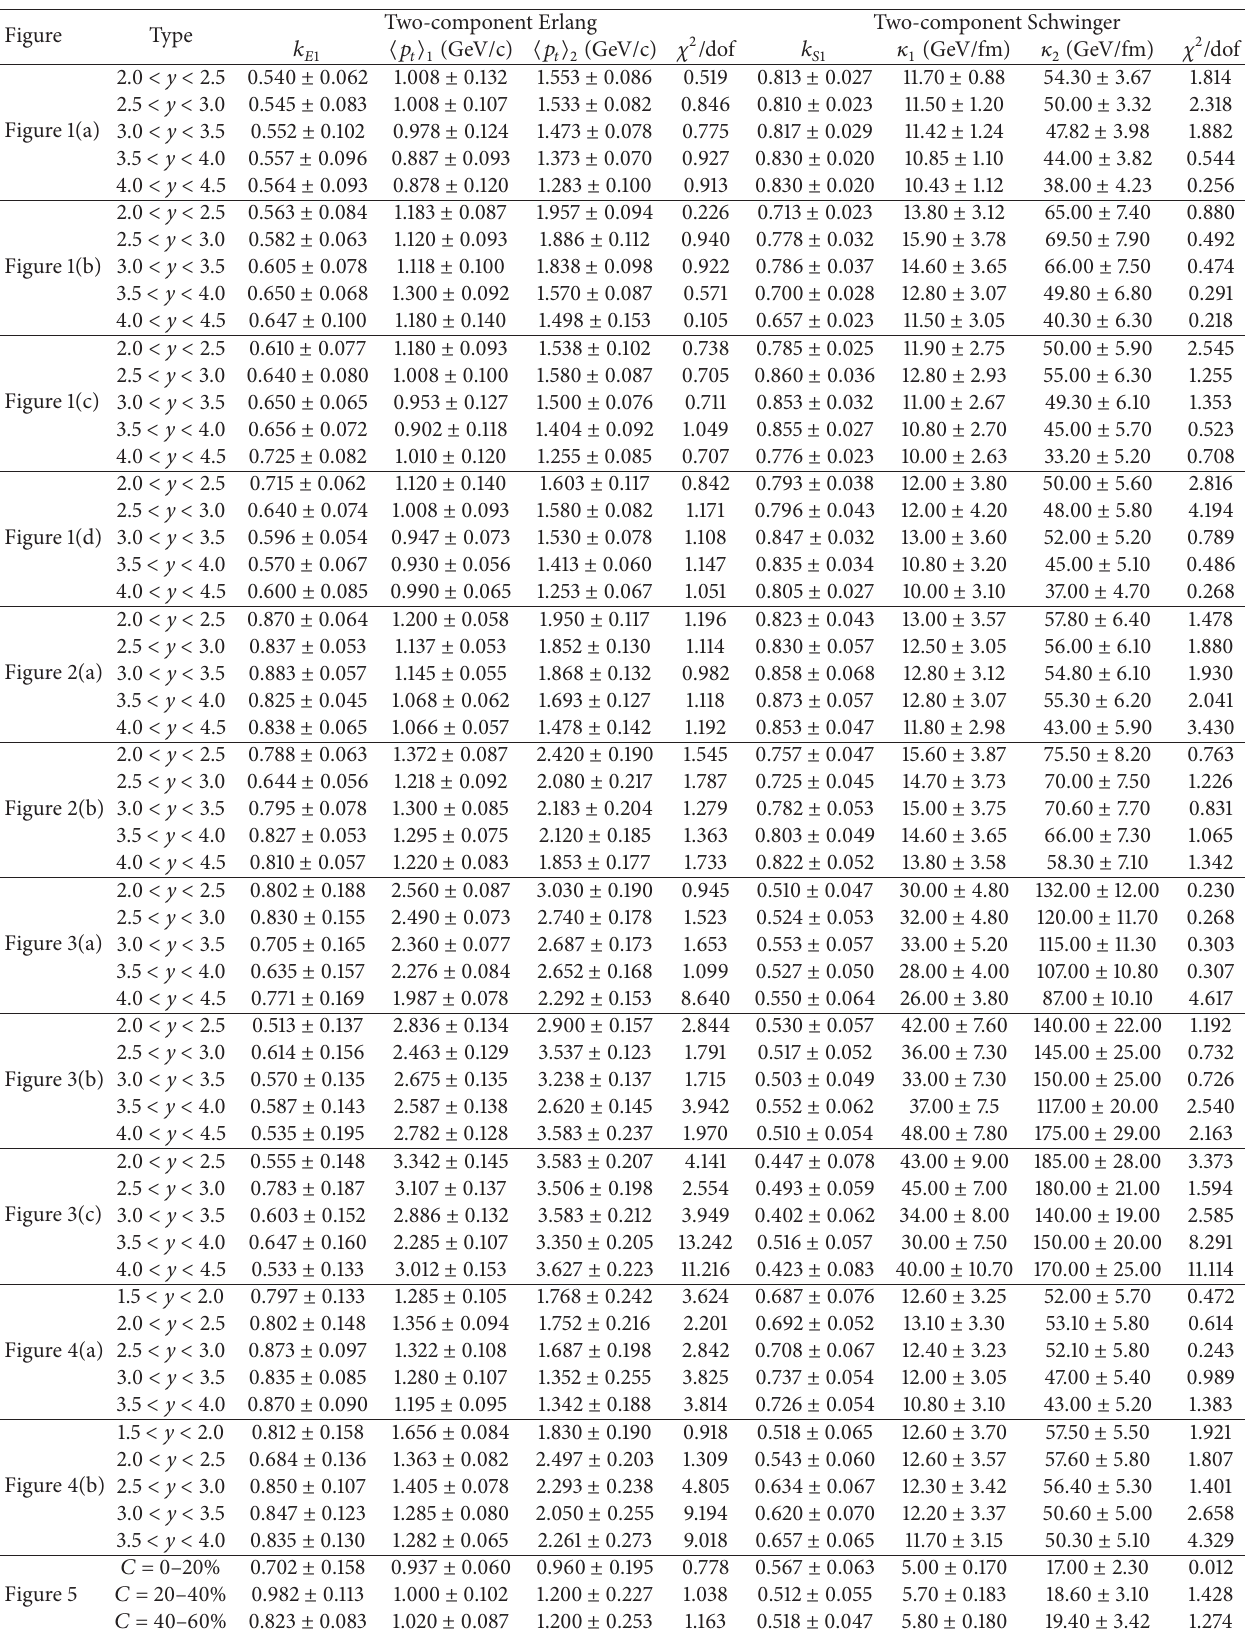
Table 1: Values of parameters and 𝜒 2 /dof corresponding to the curves in Figures